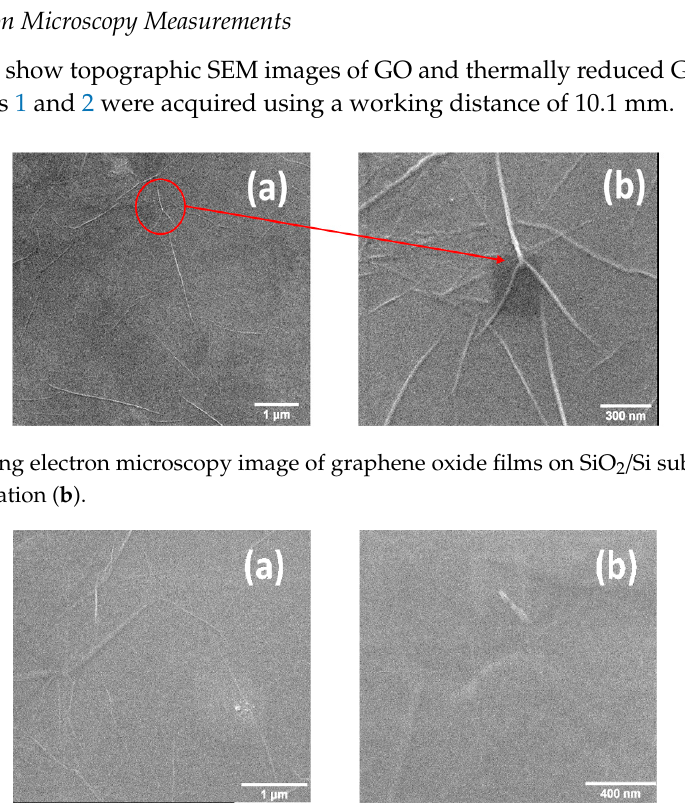
Figure 2. Scanning electron microscopy image of thermally reduced graphene oxide films on SiO 2 /Si substrates ( a ) and related magnification ( b ).